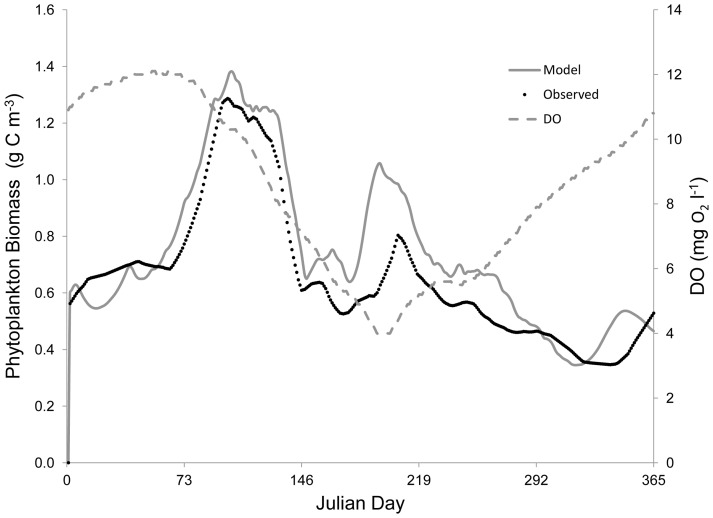
Verification of the phytoplankton state variable.Left y-axis: the gray solid line represents modeled phytoplankton biomass and the black dots denote mean observed phytoplankton biomass from site LE3.6 of the Chesapeake Bay Water Quality Monitoring Program from 1985–2001. Right y-axis: the grey dashed line indicates the dissolved oxygen concentration. Modeled phytoplankton biomass matched the trend and magnitude of observed phytoplankton biomass in 1992.